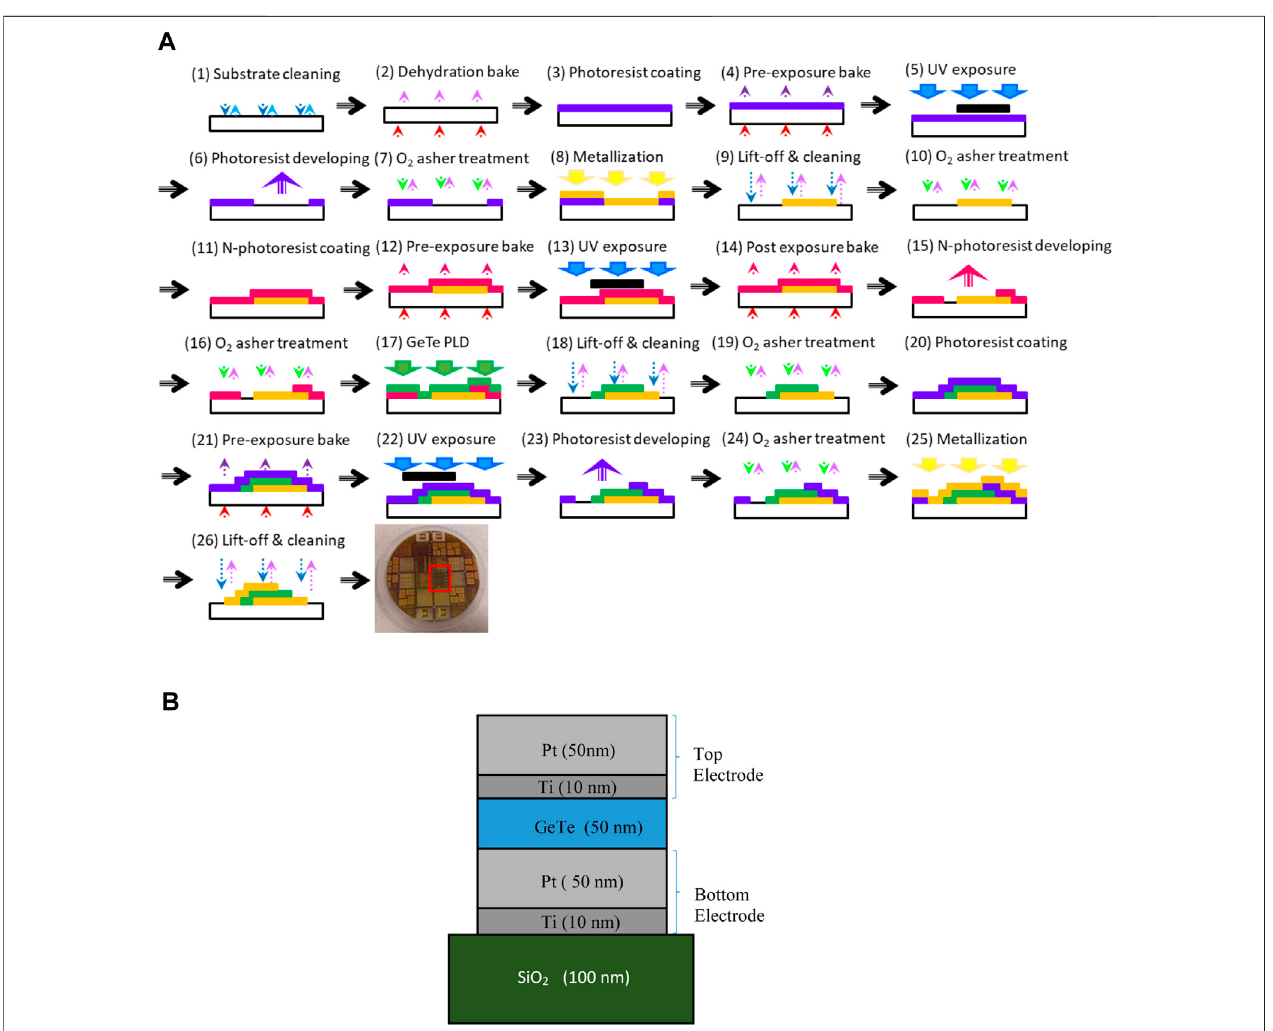
FIGURE 1 | (A) Detailed steps in the device fabrication process and (B) the cross-section of the fi nal device structure.